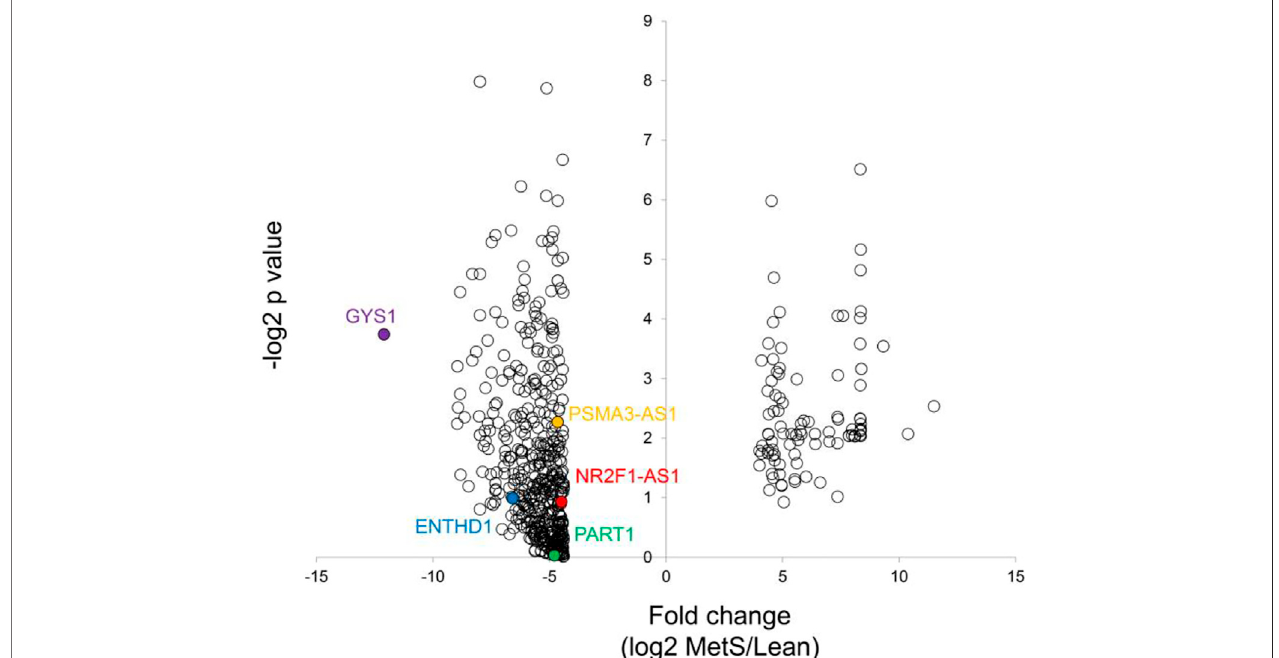
FIGURE 2 | Volcano plot of differentially expressed mRNAs in circulating MetS-EVs versus Lean-EVs.